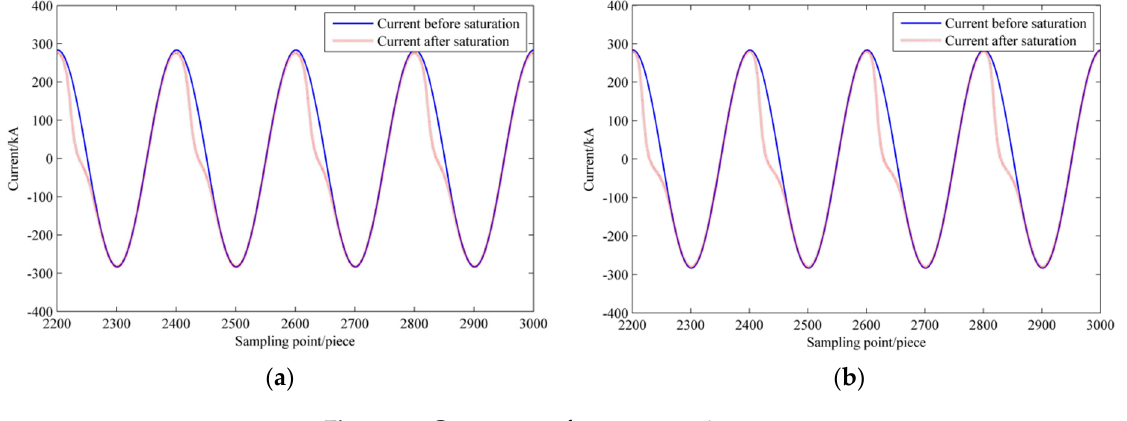
Figure 10. Current transformer saturation state.